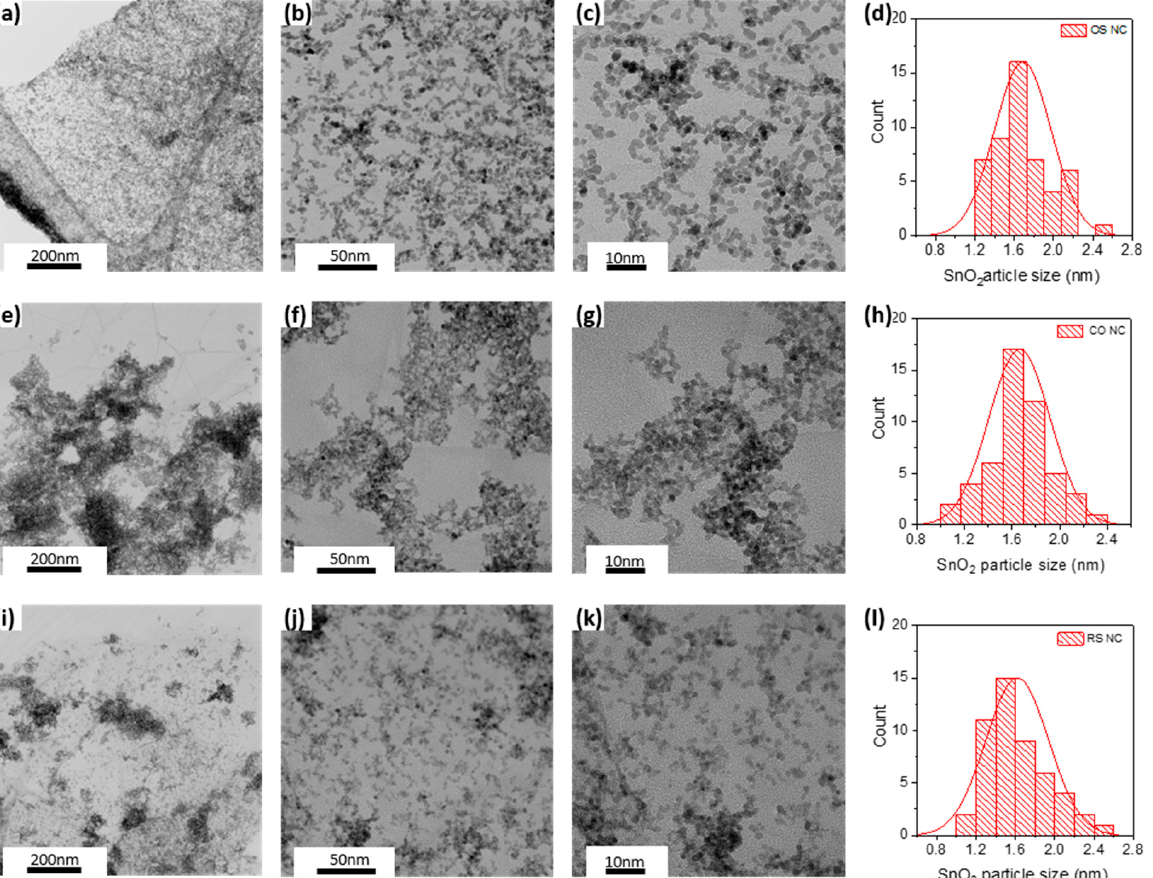
Figure 5. ( a , e , i ) Low magnification, ( b , f , j ) medium magnification, ( c , g , k ) high magnification images, and ( d , h , l ) Particle count histogram of Sn 3 O 4 of OS, CO, and RS nanocomposites.